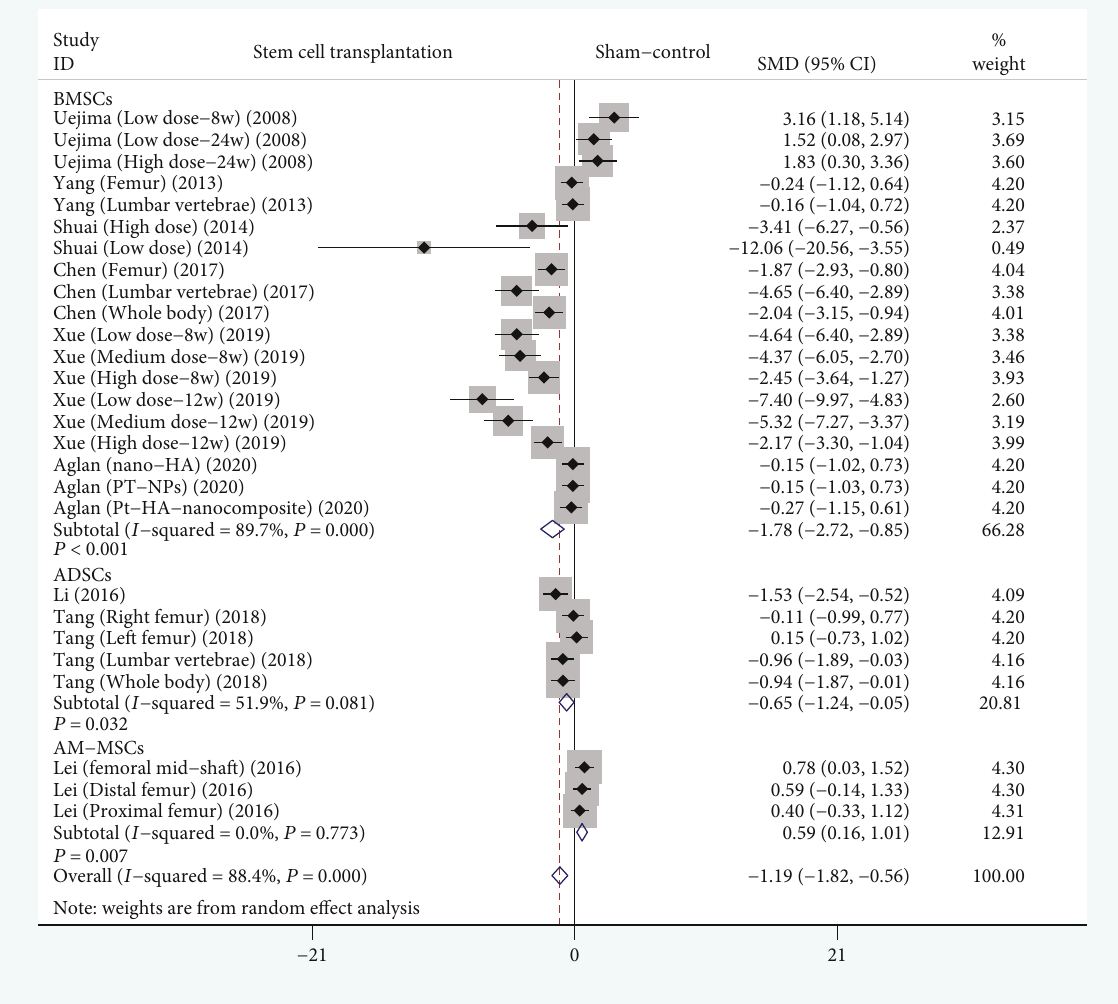
Figure 4: Forest plot showing the e ff ect of stem cell treatment group compared with sham operation group on BMD. BMD: bone mineral density; BMSCs: bone marrow mesenchymal stem cells; ADSCs: adipose-derived stem cells; AM-MSCs: amniotic membrane mesenchymal stem